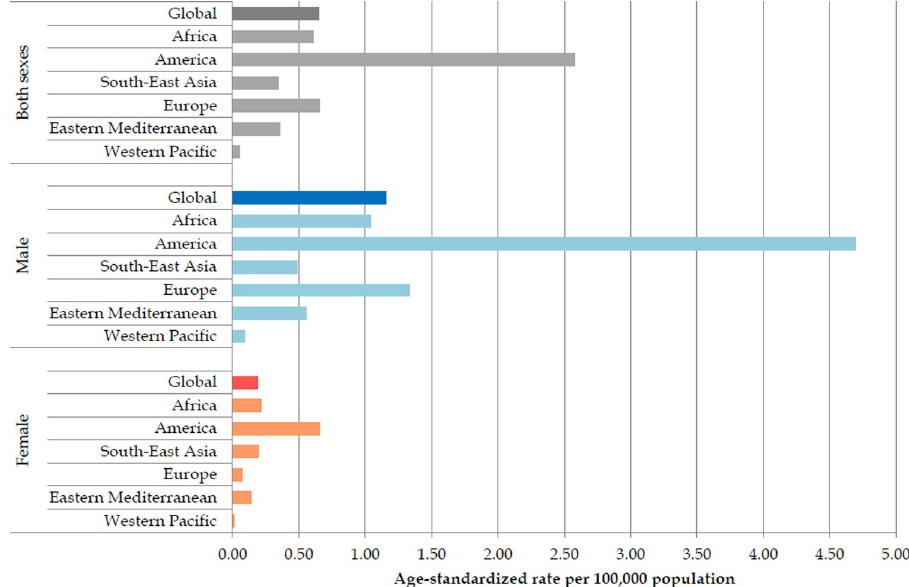
Fig 3. Age-standardized mortality rates (global and by WHO regions) of suicide by firearm, by sexes, 2019. Source: GBD estimates [20]. https://doi.org/10.1371/journal.pone.0267817.g003 Out of all 150 countries with a decline in suicide mortality, Singapore (AAPC = -6.8%), Sri Lanka (AAPC = -5.9%), Australia (AAPC = -5.6%), and Switzerland (AAPC = -5.5%) showed the most marked reductions in mortality rates. A total of 31 countries had a significant increase in suicide mortality, with Jamaica (AAPC = +11.5%) and Lesotho (AAPC = +4.4%)